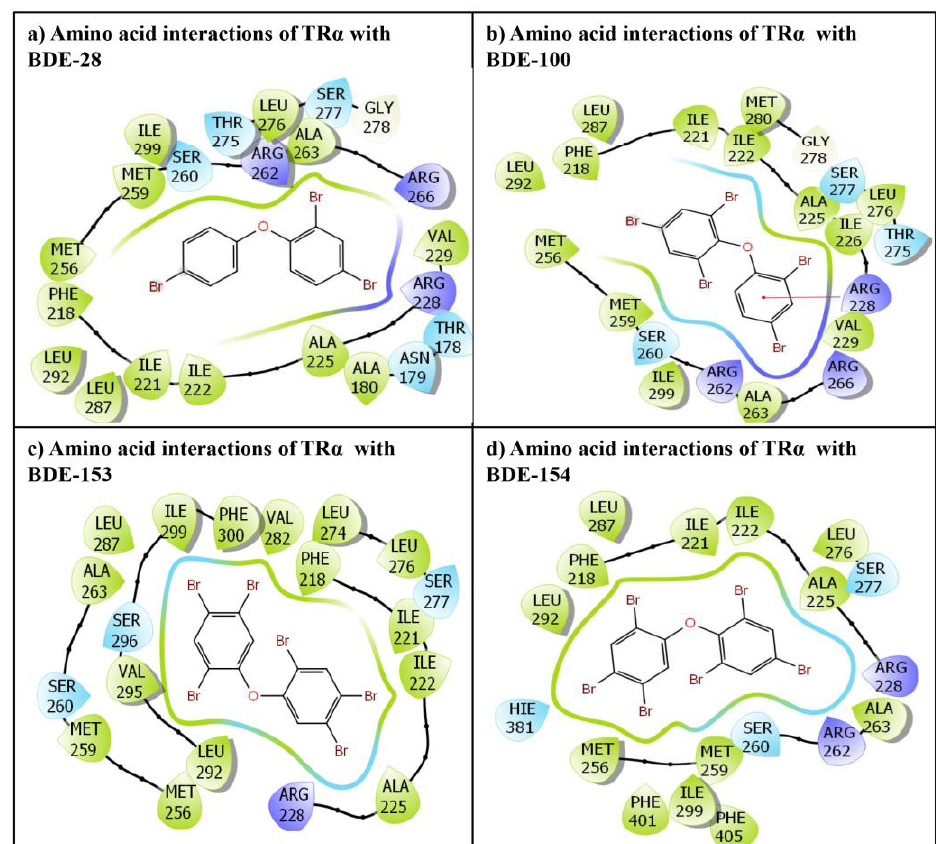
Figure 1. The molecular interactions of PBDE flame retardants ( a ) BDE-28, ( b ) BDE-100, ( c ) BDE-153 and ( d ) BDE-154 with amino acid residues in the T Rα ligand binding pocket.